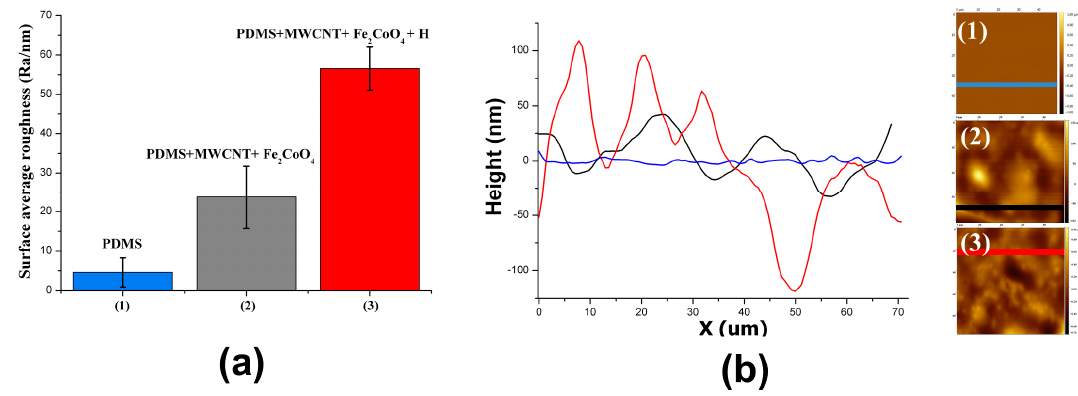
Figure 5. PDMS/filler composites: ( a ) Surface roughness. The altitude of the bars is the average roughness, R a , considering four replicates for each kind of material and three images for each sample. That is, each reported R a was calculated using 12 AFM images. The respective standard deviation is indicated on each bar. ( b ) Height profiles recorded on the straight lines indicated in the insets. (1) PDMS, (2) PDMS/MWCNT/CoFe 2 O 4 , and (3) PDMS/MWCNT/CoFe 2 O 4 cured in the presence of H . MWCNT: 1% w/w ; CoFe 2 O 4 : 2% w/w .